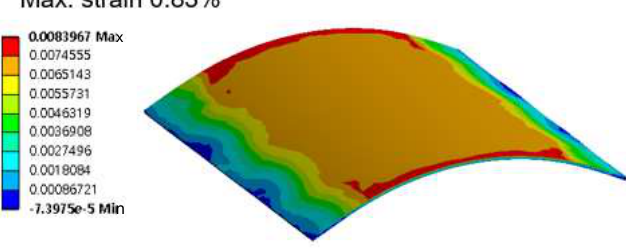
Figure 17. Maximum stress of the silicon chip at a bending radius of 6 mm.